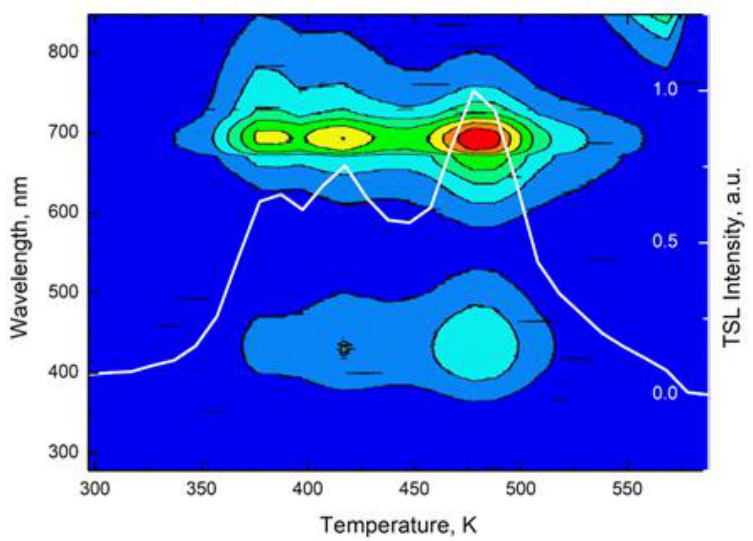
Figure 6. TSL glow curve at 693 nm (white line, right Y scale) overlayed on top of full measurement matrix (left Y scale). X-scale is joined between an overlay and a matrix. Color represents the intensity of the 2D graph (temperature to wavelength).